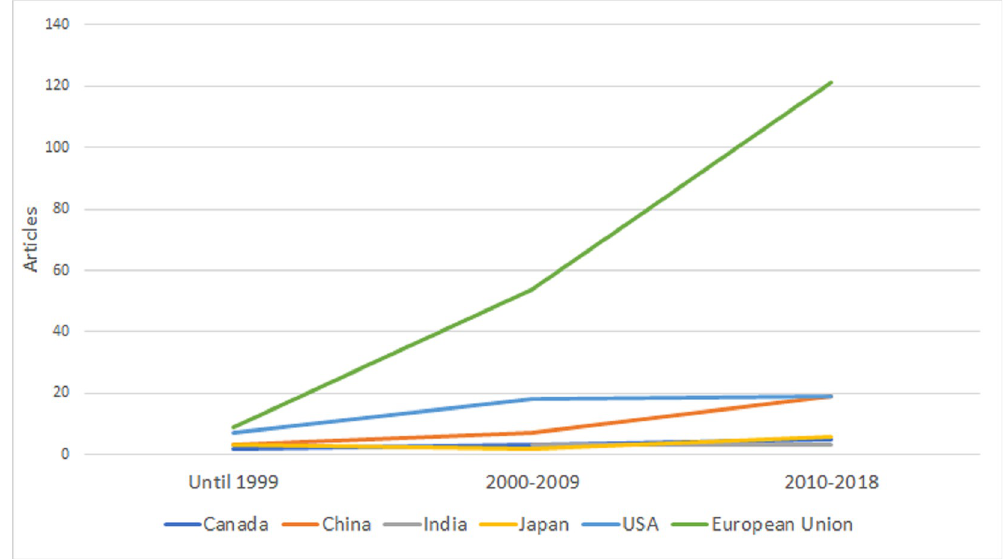
Fig 2. Evolution of published articles in the field of biocontrol using Aureobasidium pullulans strains by country. The vertical axis represents the number of articles published in each of the 3 periods analyzed (until 1999, 2000–2009, and 2010– 2018) by country (Canada, China, Japan, and the USA) or regulatory region (European Union).